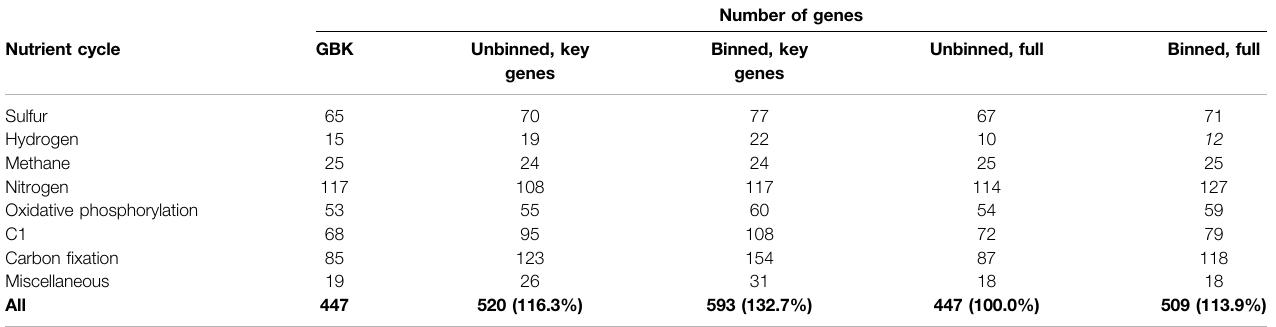
TABLE 4 | Number of genes retrieved from the GenBank fi les of the mock community and four different Metascan analyses, ordered by cycle. Percentages state the percentage relative to the total number of genes recovered from the GenBank fi